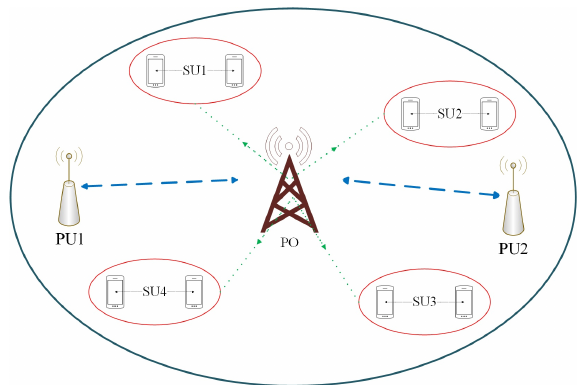
Figure 1: A cognitive radio network with four SUs operating over an area covered by a licensed PO. The spectrum under-used by primary users (PUs) are shared with